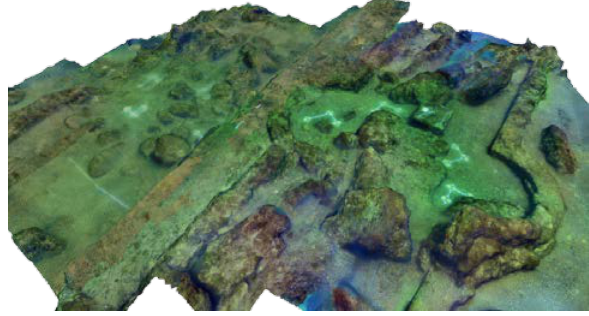
Figure 4. Final textured 3D model of Villa dei Pisoni